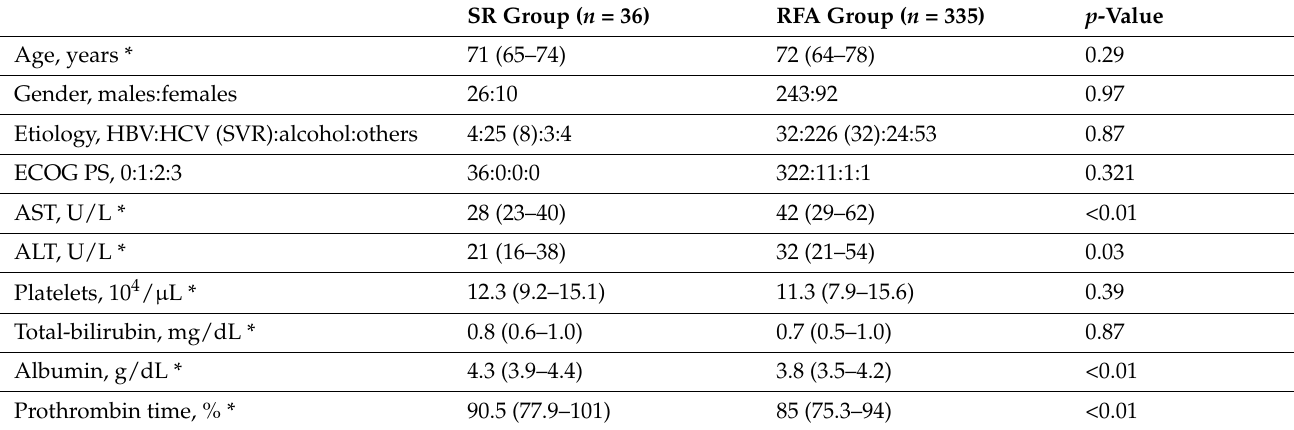
Table 1. Characteristics of patients ( n =